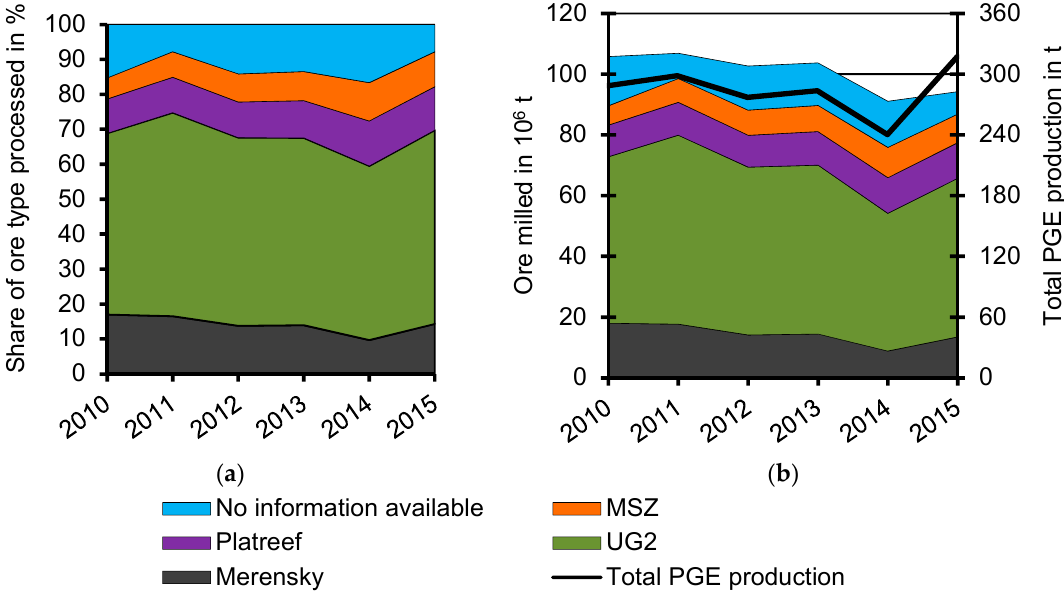
Figure 5. Processed ore types, total 6E PGE production ( a ) and share of milled ore type ( b ).